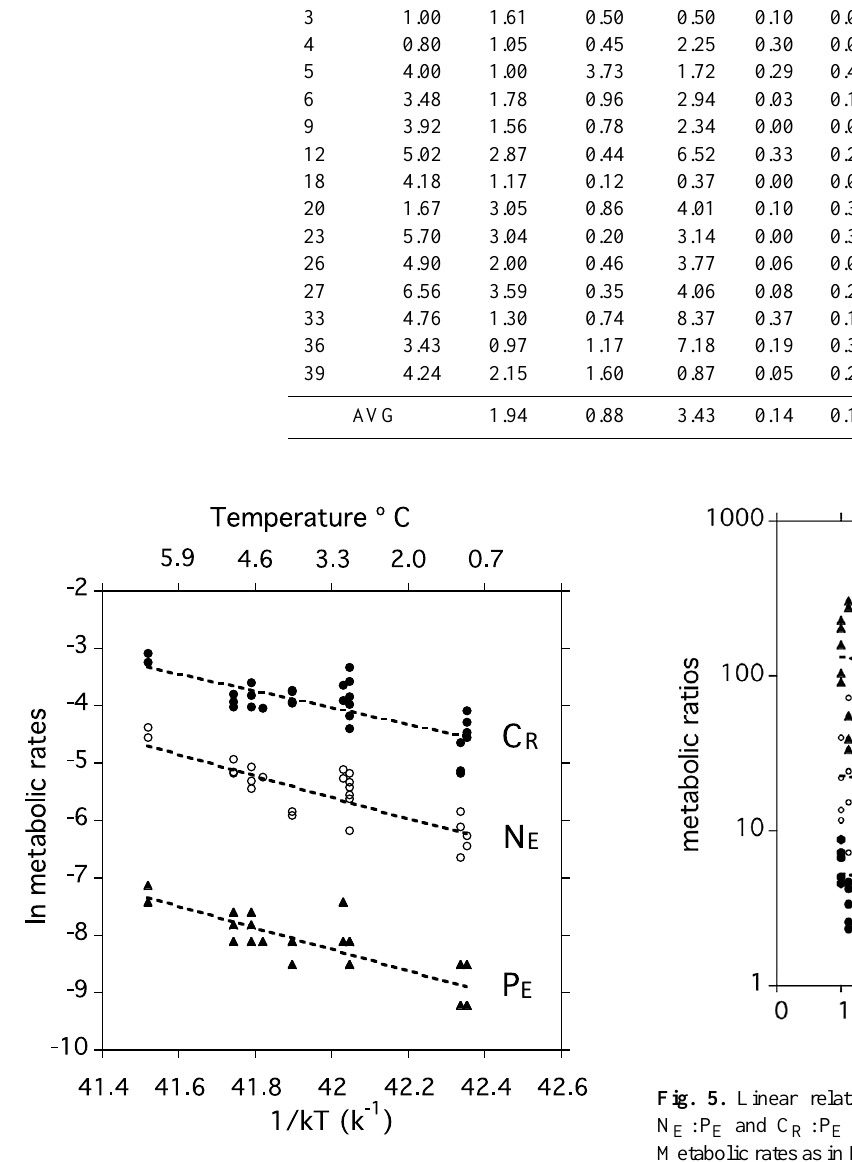
Fig. 4. Arrhenius plots for specific respiration (C R ) and excretion rates (N E and P E ) . Abscissae: 1000 (1/K; down) and temperature ( ◦ C; up). Ordinates: ln specific metabolic rates in µmol (C R , N E and P E ) µmolC − 1 zoo day − 1 .